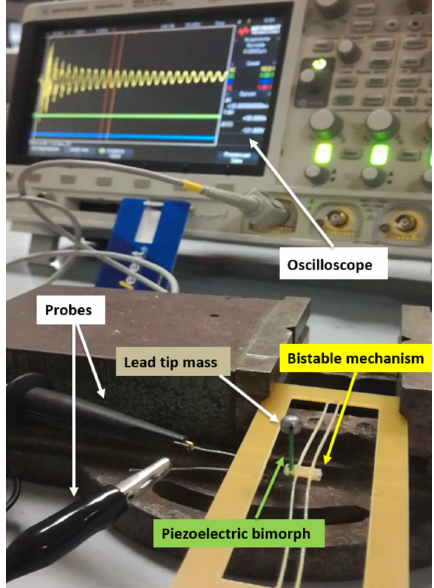
Figure 7. Experimental setup for model B.